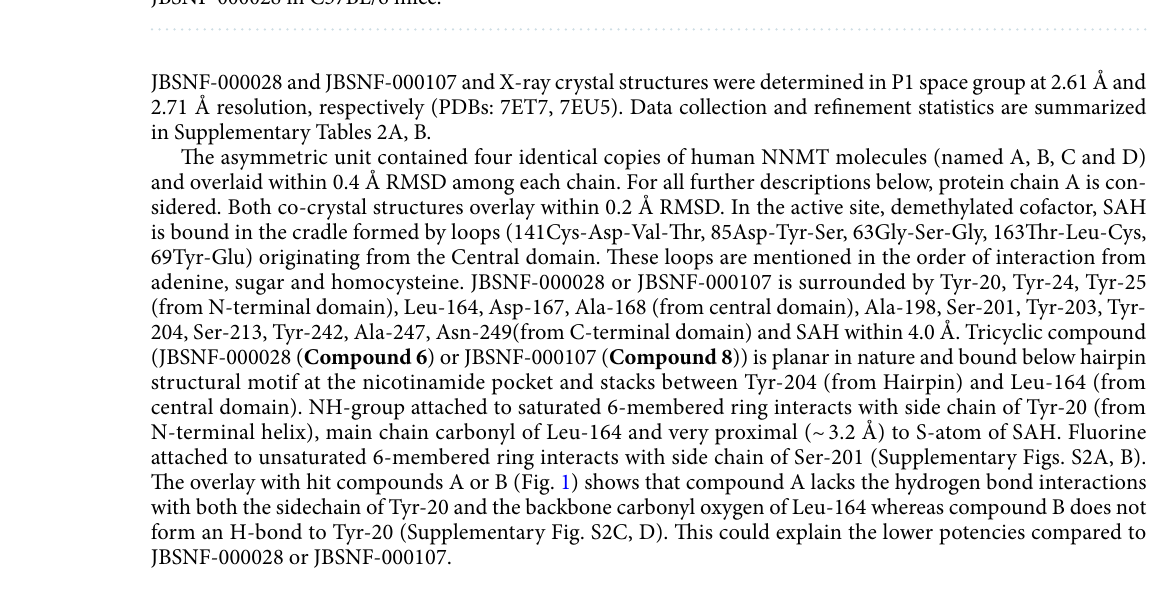
Figure 4. JBSNF-000028: Pharmacokinetics profile and target engagement. ( A ) Plasma concentration versus time profile of JBSNF-000028 in C57BL/6 mice. ( B ) Plasma levels of MNA confirming target engagement by JBSNF-000028 in C57BL/6